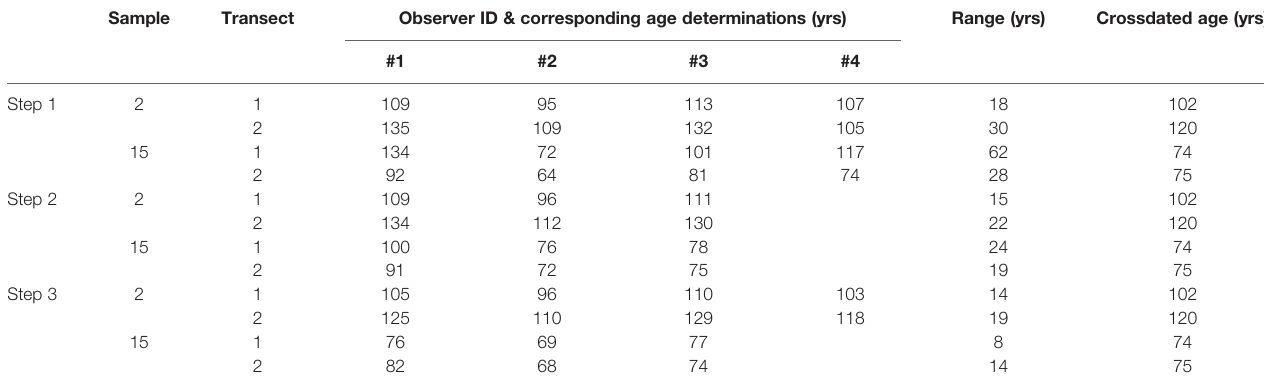
TABLE 1 | Results of inter-observer study reporting number of years identi fi ed in each transect after each step outlined in methods section